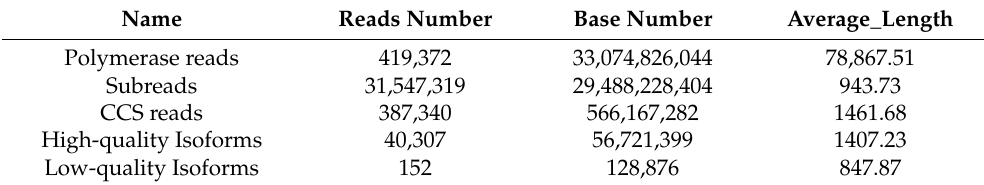
Table 1. Overview of the Single-Molecule Real-Time sequencing in Populus ussuriensis